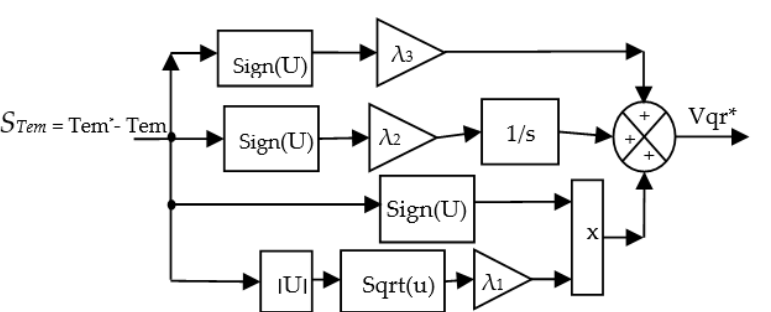
Figure 4. Proposed TOSMC torque controller.